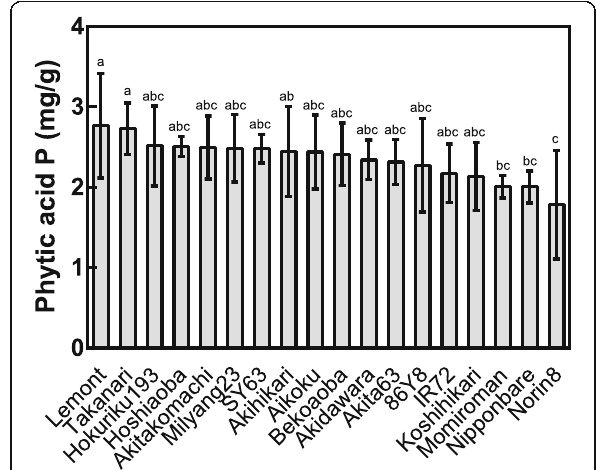
Fig. 1 PA-P content of different rice cultivars. The raw data were taken from experiments conducted in Tsukuba, Japan (Dietterich et al. 2015). The average value of the PA-P content and standard deviation for each cultivar are presented in the figure. Means followed by the same letter denote no significant differences according to Tukey ’ s test ( P